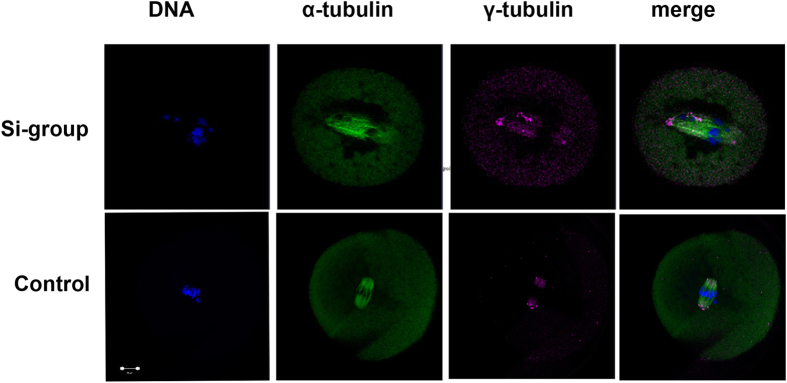
Knockdown of Cep55 causes disassociation of γ-tubulin from spindle poles.Oocytes injected with Cep55 siRNA or control siRNA were cultured in fresh M16 medium for 8 h after 24 h arrest at the GV stage by IBMX, followed by staining of α-tubulin (green), γ-tubulin (purple) and DNA (blue) in the control group; γ-tubulin was associated with the spindle poles at the MI stage, whereas in the Cep55 knockdown group, γ-tubulin dissociated from abnormal spindle poles. Bar = 20 μm. A total of 160 oocytes (47 + 52 + 61) were assessed in the si-group and 166 oocytes (57 + 57 + 52) were assessed in the control group.